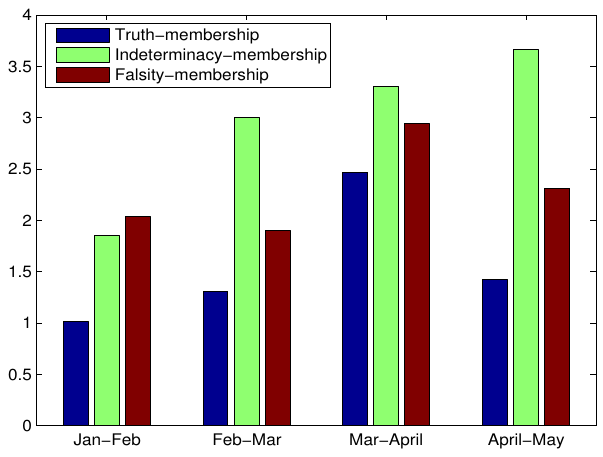
Figure 14. Laplacian energy of single-valued neutrosophic graphs.